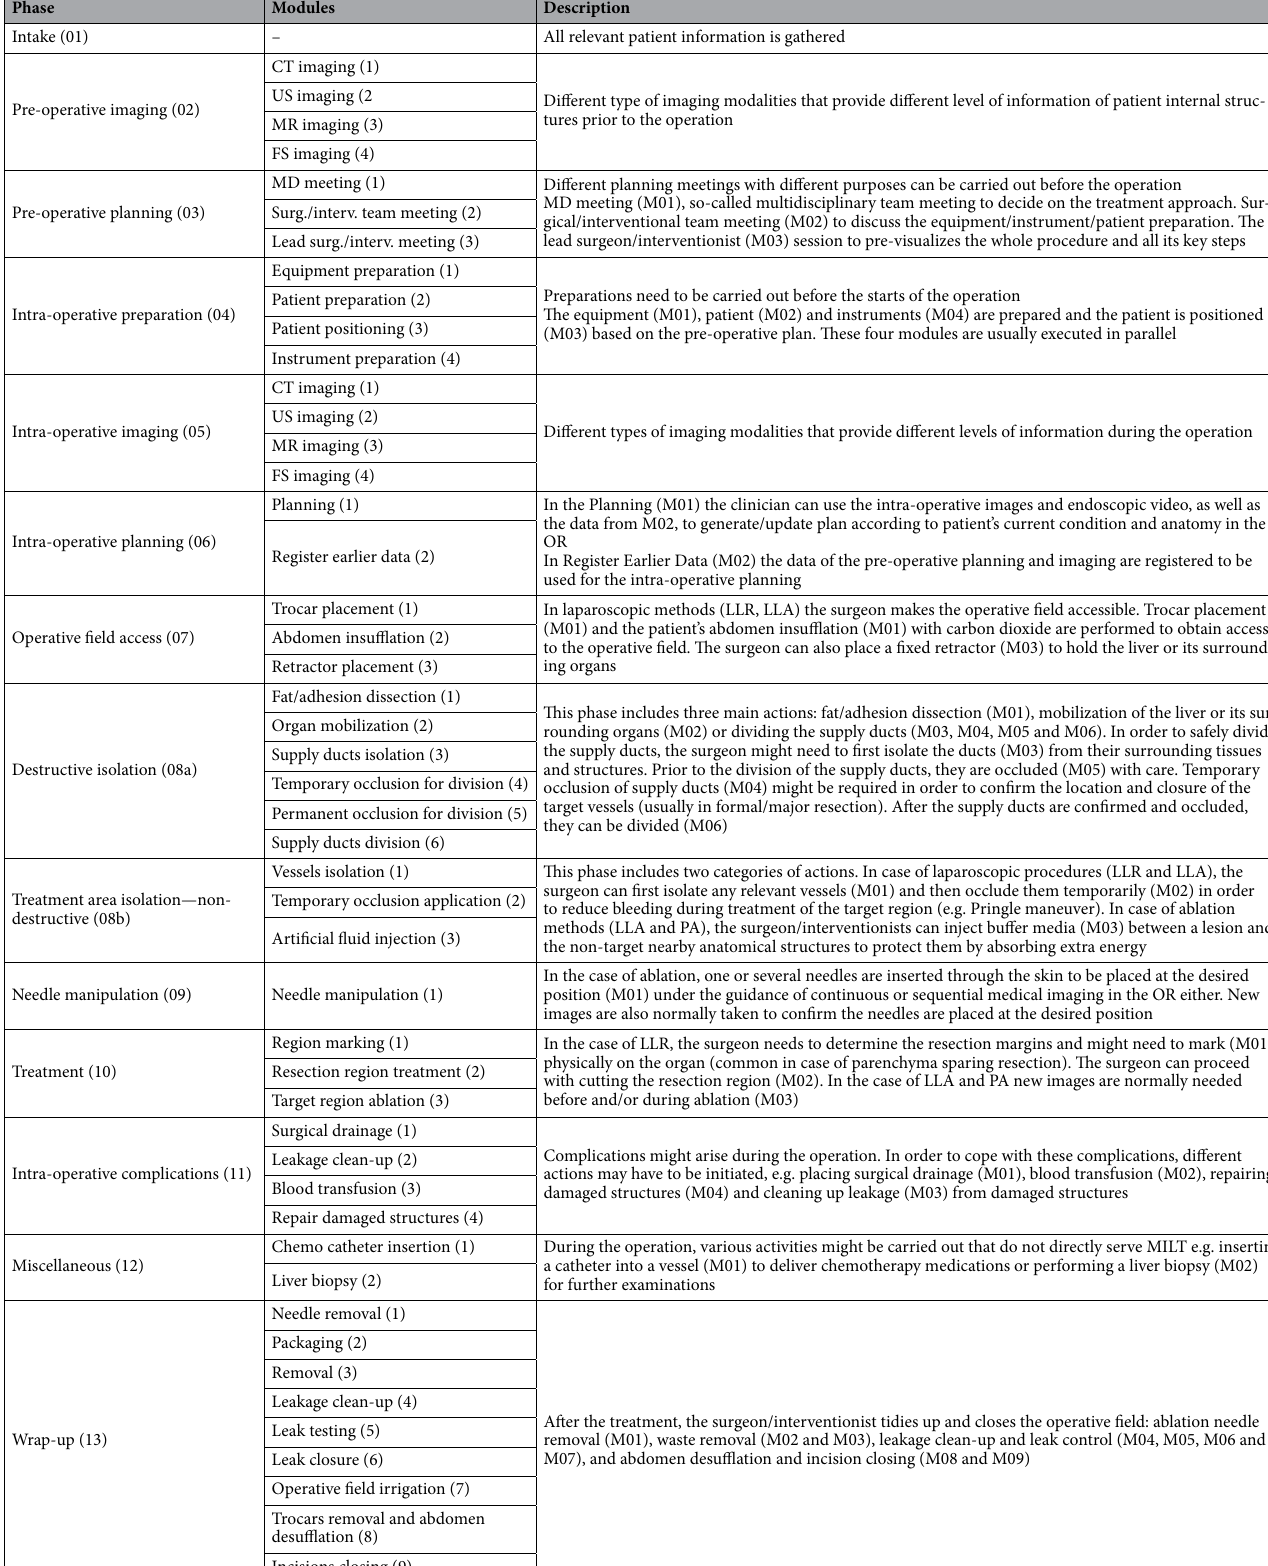
Table 1. Different phases of generic process model of MILT and the corresponding modules according to Fig.